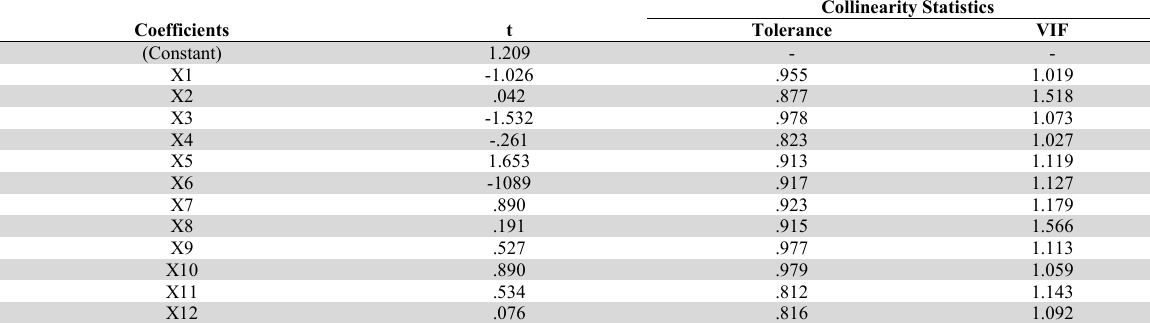
Multicollinearity test results